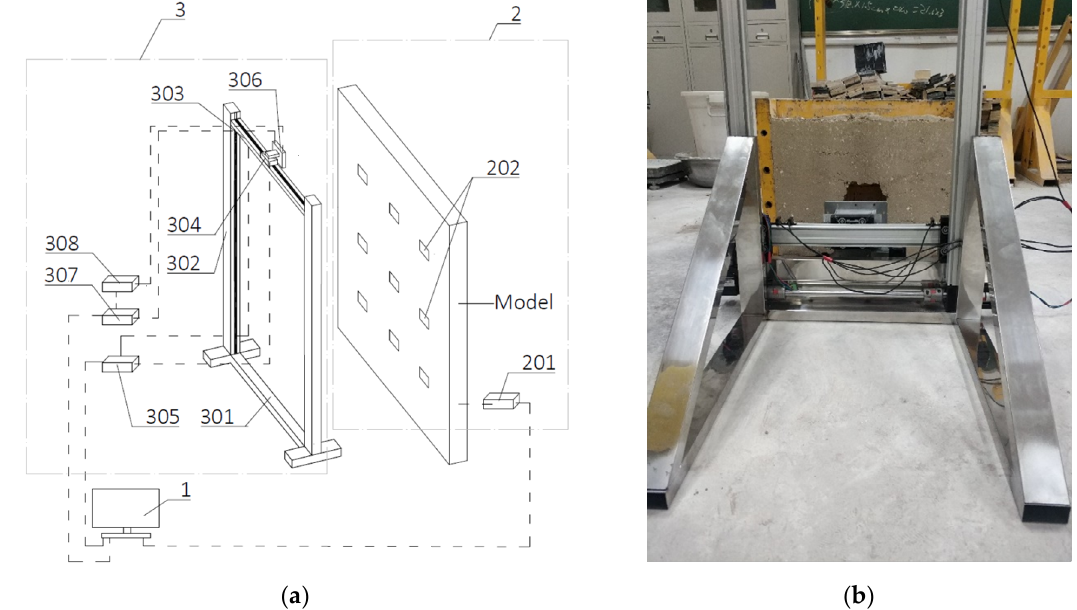
Figure 11. ( a ) Schematic diagram of the structure of the intelligent device. 1. Master controller; 2. Humidity and temperature monitoring system; 3. Mobile microwave irradiation system; 201. Humidity and temperature signal processor; 202. Humidity and temperature-sensitive components; 301. Base; 302. Vertical chute; 303. Horizontal conduit; 304. Load slide; 305 Displacement driver; 306. Microwave generator; 307. microwave controller; 308. microwave adapter power supply. ( b ) A physical image of the smart device.